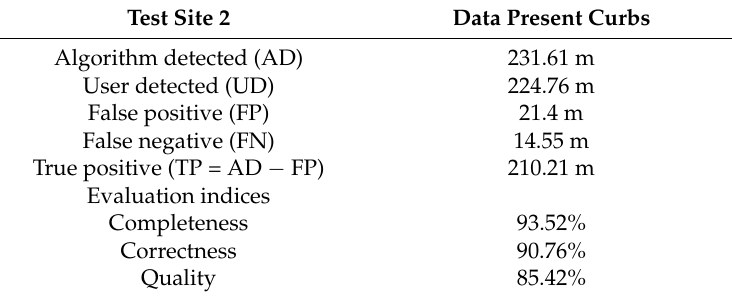
Table 4. Accuracy of the detection method at Test Site 2.